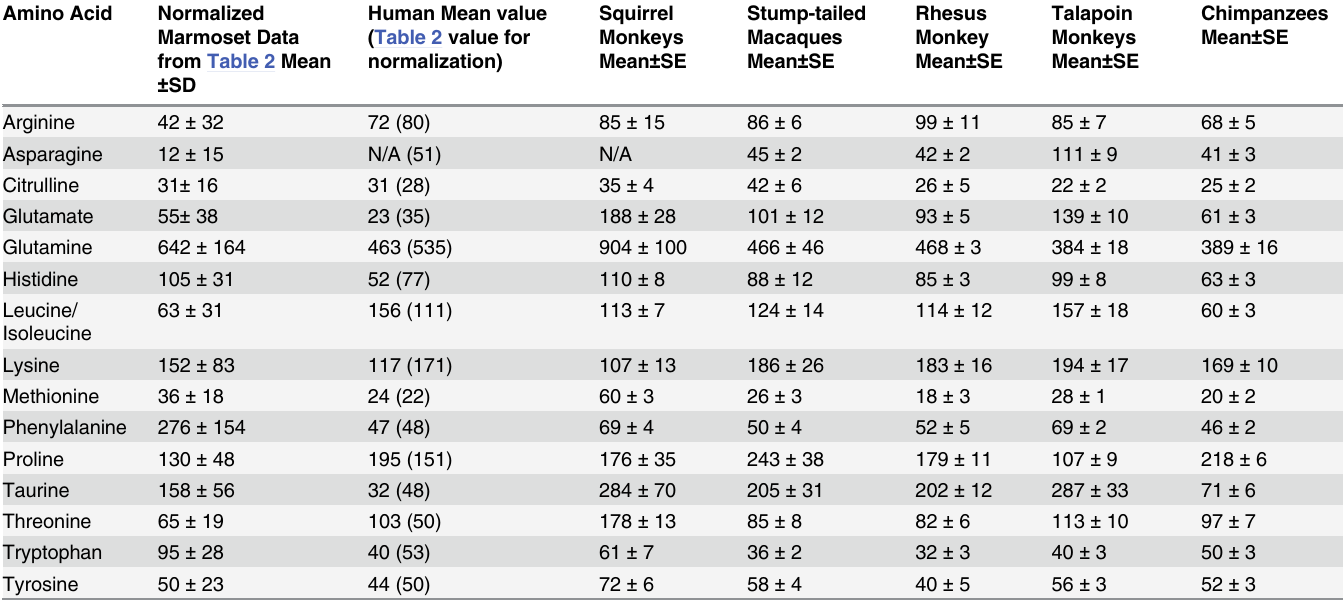
The original data of Peters et al, expressed as mg/dL, were converted to micromolar concentrations. To facilitate comparisons, marmoset data in this Table were normalized based upon the human concentration for the respective amino acid in Table 2 (given in parentheses) and the corresponding value provided by Peters et al. All concentrations are expressed as micromolar